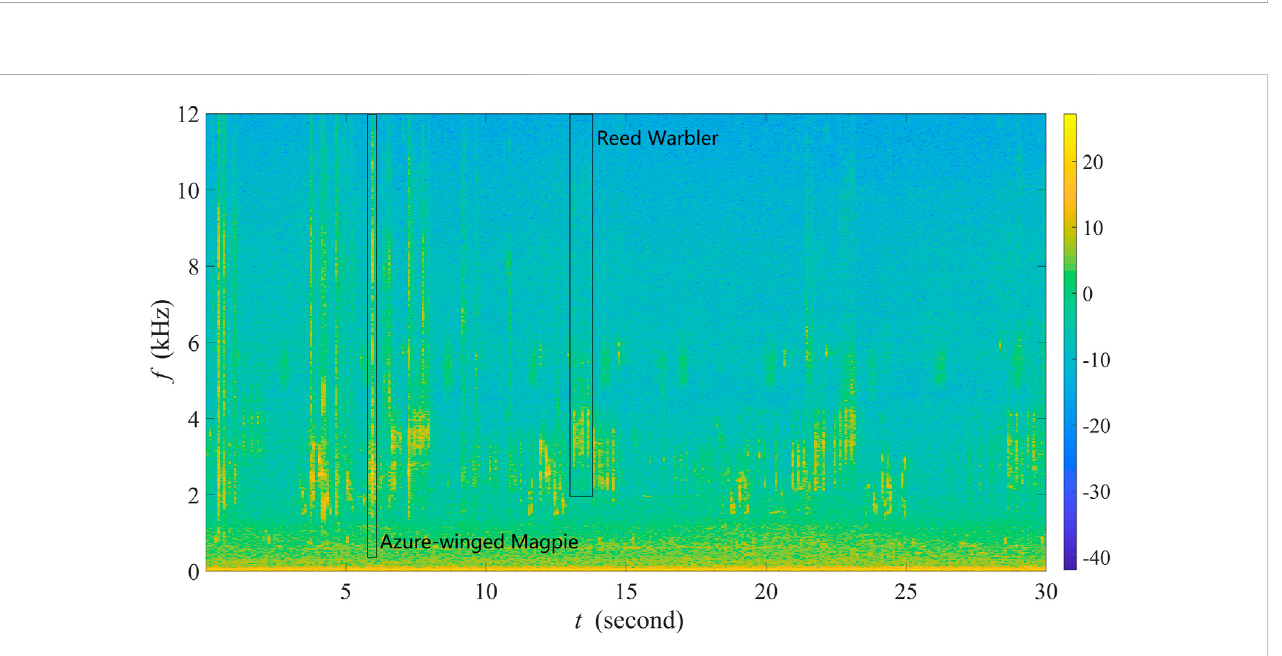
Frontiers in Remote